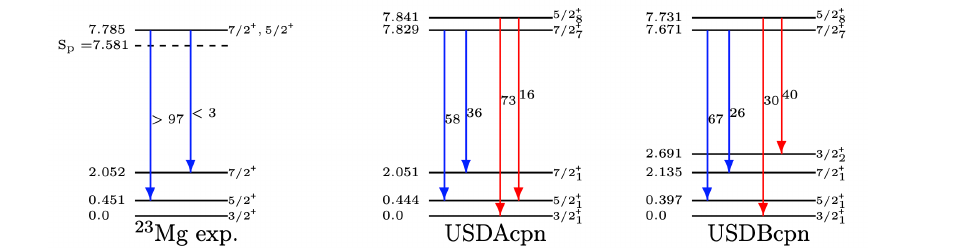
Figure 3. Comparison between γ -ray transitions from the E x = 7.785 state and from shell-model + + candidates: (n SM = 7, J π = 7 ) and (n SM = 8, J π = 5 ) . A good agreement is observed for the blue transi- 2 2 7 8 tions, strengthening the n SM = 7 candidate as the E x = 7.785 MeV state (intensities are given in %.)